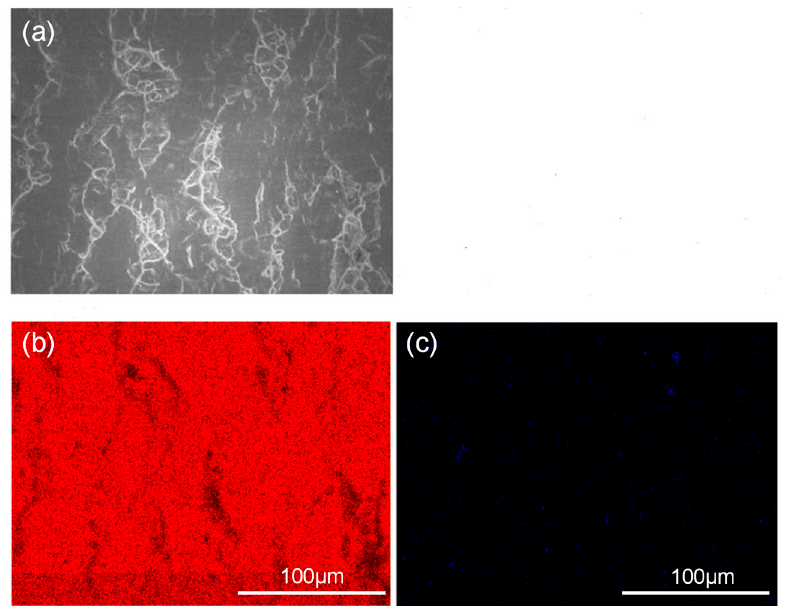
Figure 10. SEM images of the peeled surface on the aluminium side of specimen C3. ( a ) Secondary electron SEM micrographs; ( b ) distribution of Al element (red areas) in ( a ) obtained by EDS; ( c ) distribution of Ti element (blue areas) in ( a ) obtained by EDS.